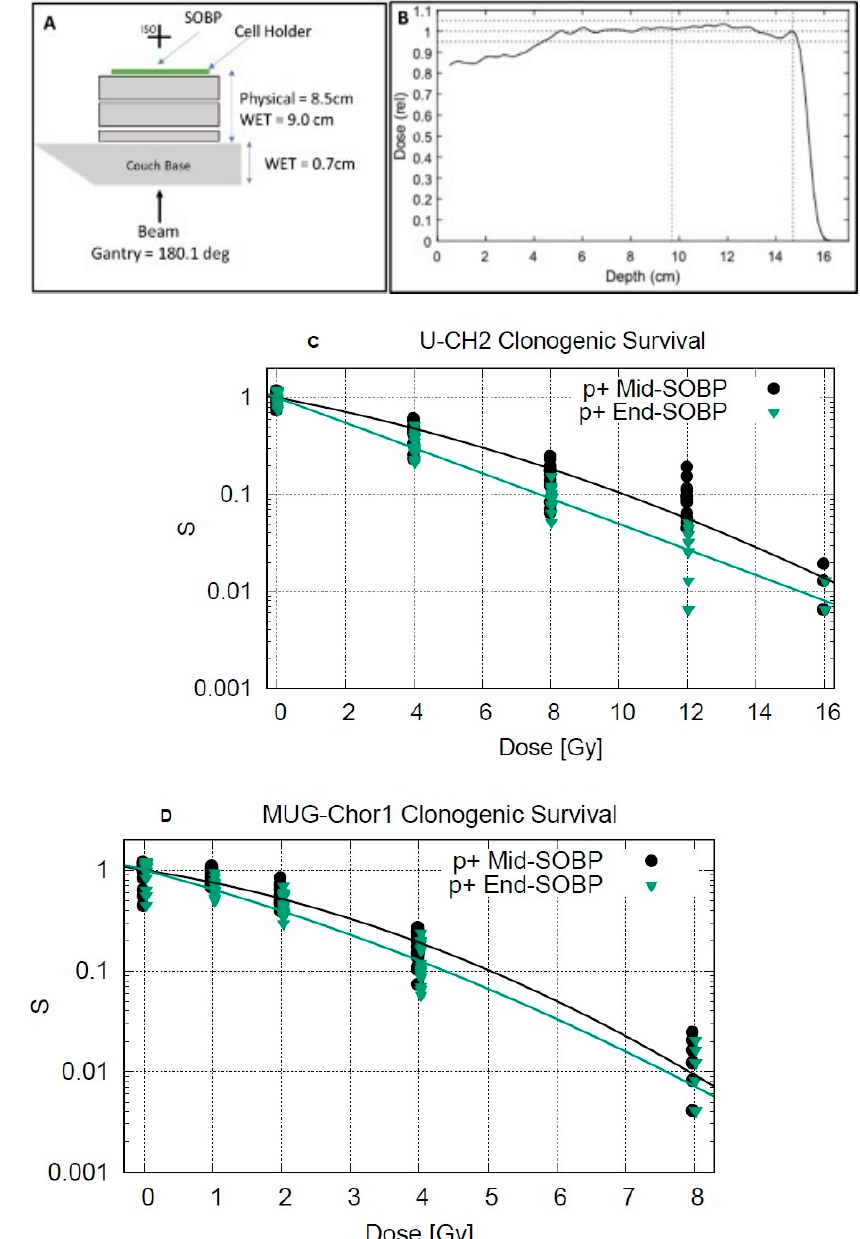
Figure 2. ( A,B ) Schematic diagram to show proton radiation treatment to cells. Cell survival of chordoma cell lines ( C ) U-CH2 and ( D ) MUG-Chor1 after proton radiation at the M-SOBP and E-SOBP.